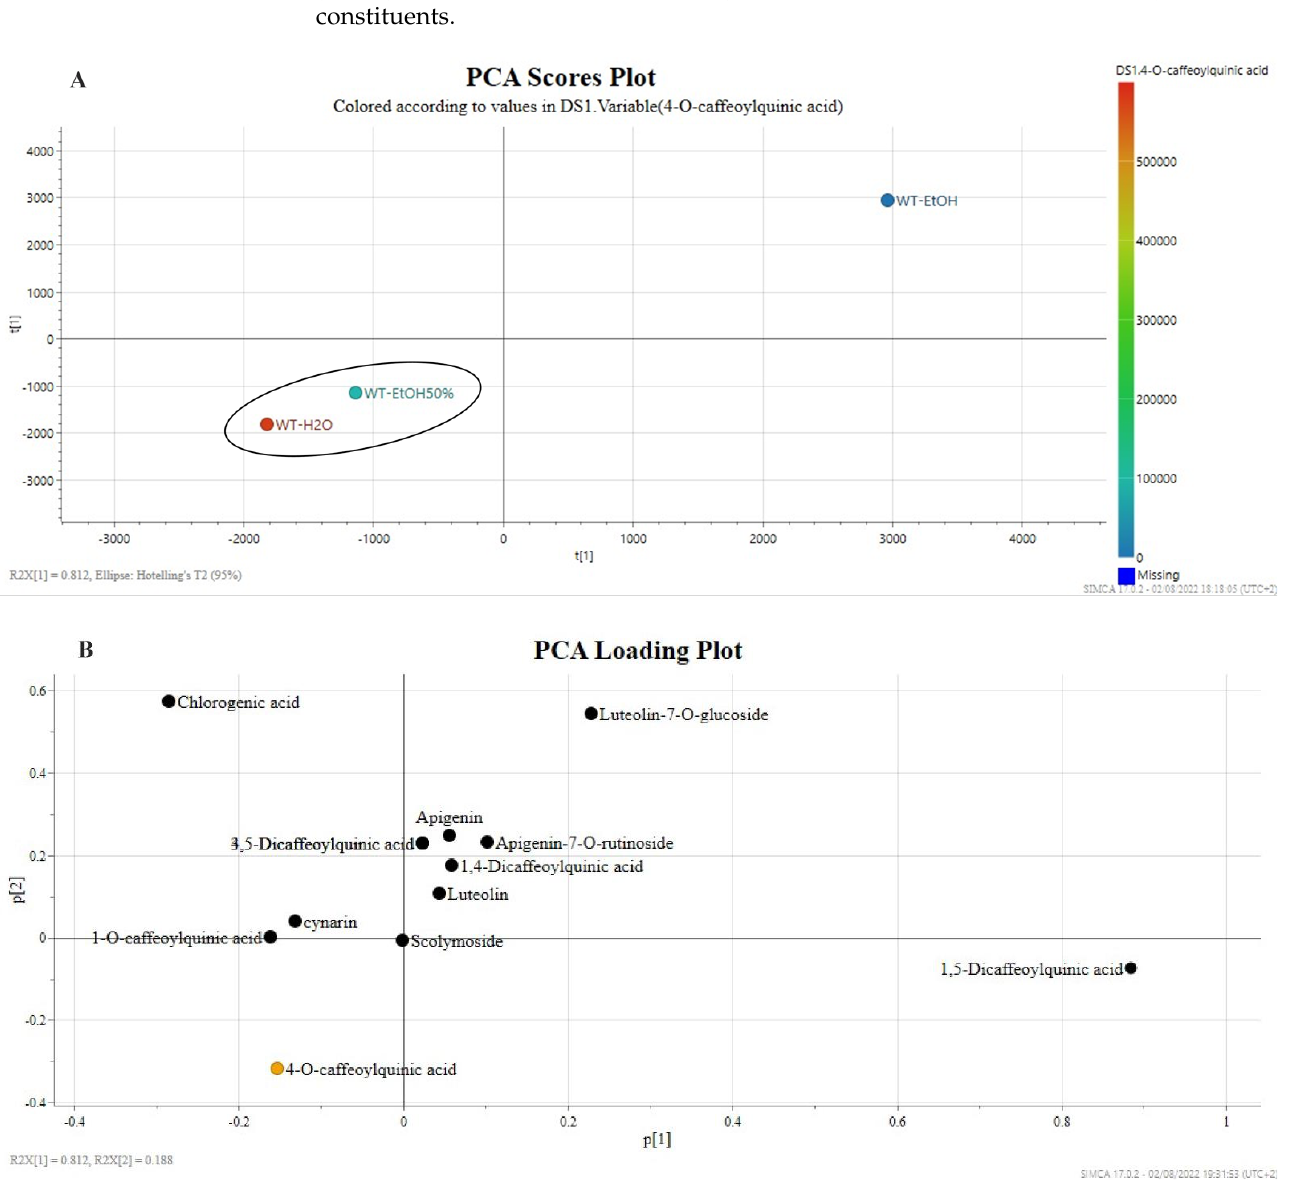
Figure 3. Supervised PCA regression plots of green extracts of C. cardunculus leaves. Scores plots ( A ) and loadings plots ( B ). WT_EtOH: ethanol extract of C. cardunculus wild-type; WT_H 2 O: water extract of C. cardunculus wild-type; WT_EtOH50%: ethanol/water (50% v / v ) extract of C. cardunculus wild-type. The coloured bar on the right side of panel A indicates the incidence of 4- O -caffeoylquinic acid in the different extraction conditions.